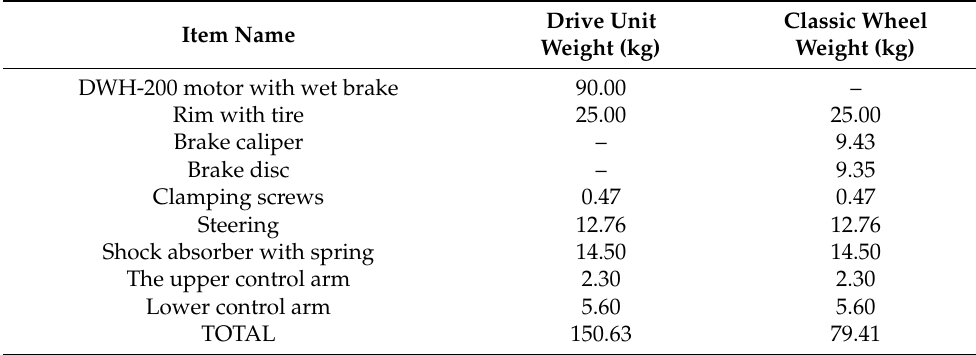
Table 1. Weights of the tested drive module with the DWH-200 motor.